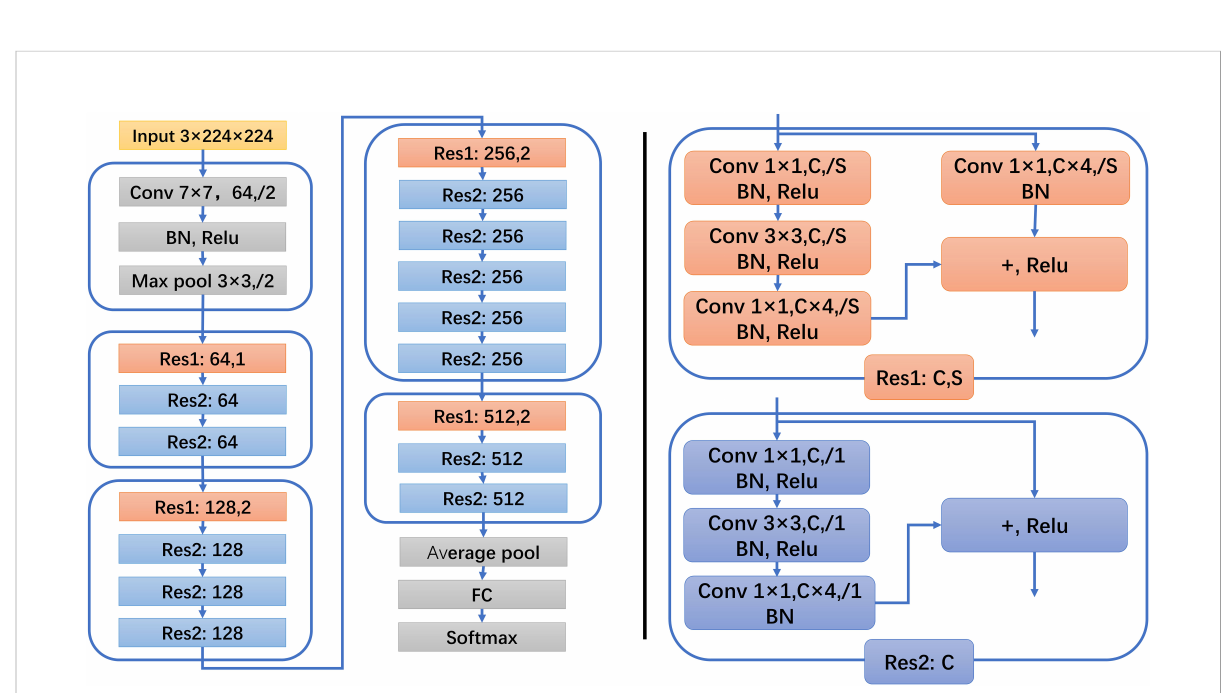
FIGURE 3 ResNet50 architecture. Res1 and Res2 represent two kinds of residual block structures, C represents the number of convolution kernels, and S represents the step